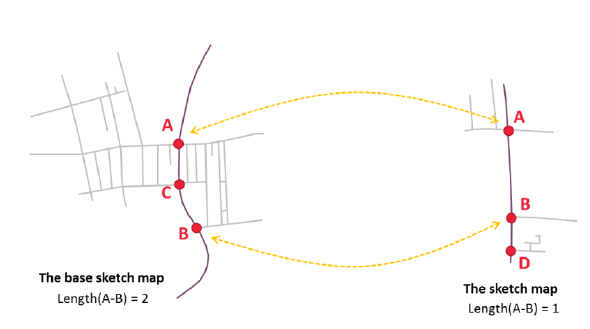
Figure3. Integration of routes in sketch maps The segments that exist exactly in sketch map and the basic map,